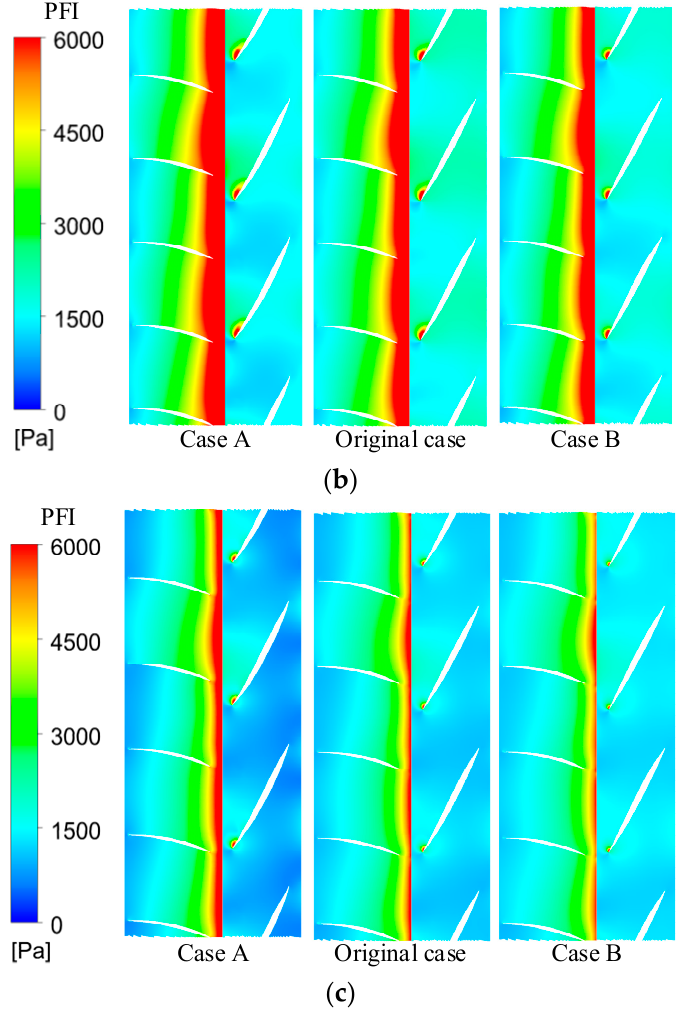
Figure 12. The distribution of PFI in the passage of impeller and guide vanes under ( a ) 0.7 Q ’ des , ( b ) 1.0 Q ’ des and ( c ) 1.15 Q ’ des . (Span = 0.5).